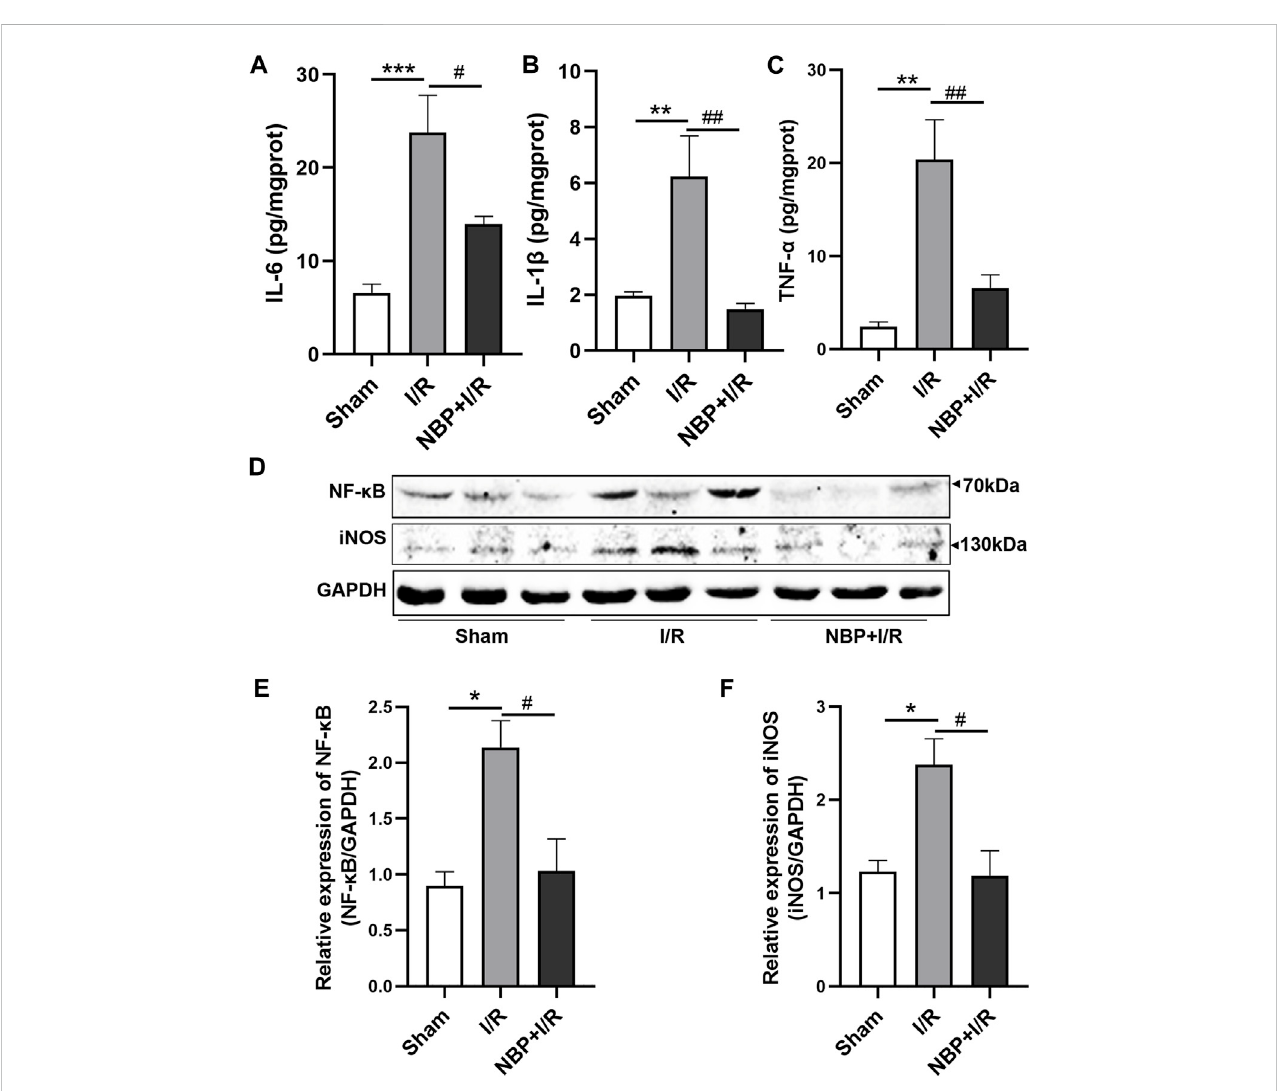
EffectsofNBPonin fl ammationontheinfarctedcerebralhemisphereinI/Rrats. (A – C) EffectsofNBPonin fl ammatorycytokinesincludingIL-6,IL-1 β and TNF- α . The concentrations of the three cytokines were signi fi cantly increased after I/R surgery and signi fi cantly decreased after NBP treatment. (D – F) Effects of NBP on the NF- κ B/iNOS pathway. Data are expressed as the mean ± SEM and were analyzed by one-way ANOVA ( post hoc analysis: Tukey ’ s post hoc analysistest).*( p < .05),**( p < .01)and***( p < .001)representsigni fi cancecomparedtotheshamgroup. # ( p < .05)and ## ( p < .01)representsigni fi cance compared to the I/R group ( p < .01). NBP dose: NBP + I/R, 9